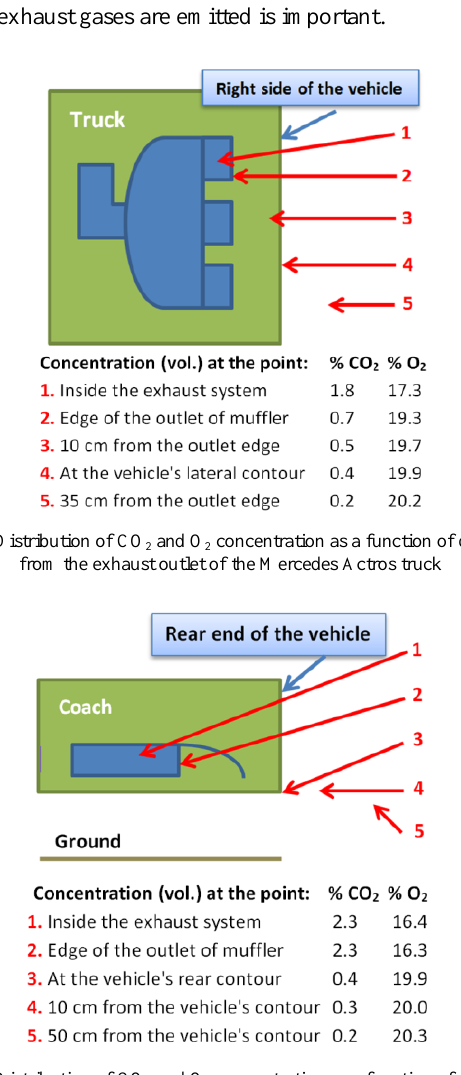
Fig. 6. Distribution of CO 2 and O 2 concentration as a function of distance from the exhaust outlet of the Mercedes Tourismo coach